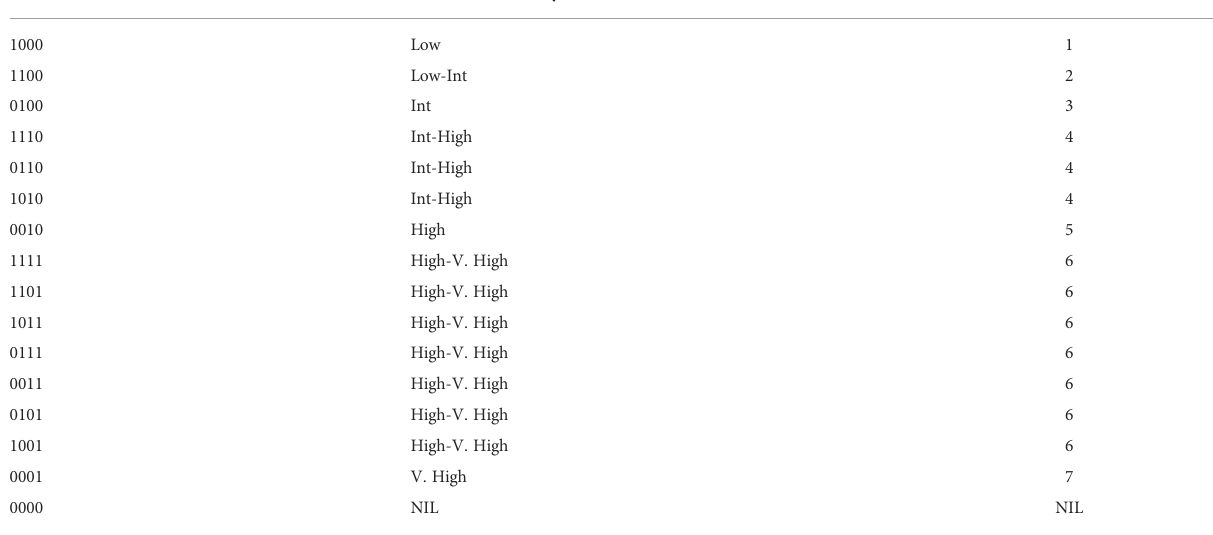
TABLE 2 Conversions of concatenated One-Hot encoded values to One-Hot Score representing disease rating and severity classi fi cation to be used in GWAS analysis. One-Hot Encoded